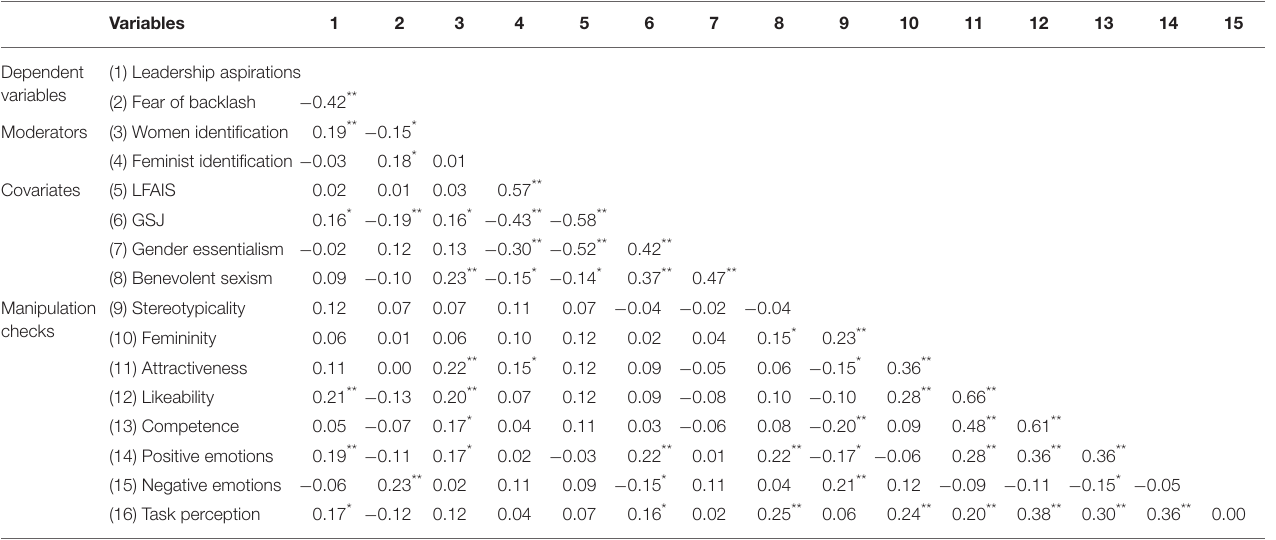
TABLE 3 | Bivariate correlations between dependent variables, moderators, covariates, and manipulation checks. Variables 1 2 Dependent